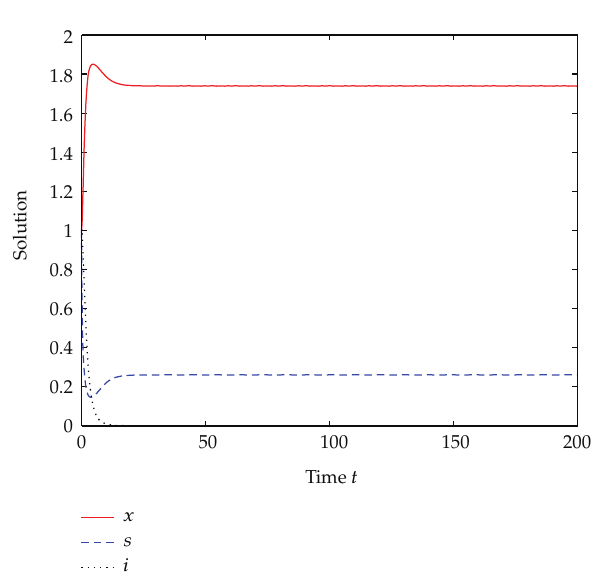
Figure 1: The temporal solution found by numerical integration of system (cid:4) 1.1 (cid:7) with r (cid:8) 2 , K (cid:8) 2 , a (cid:8) 2 , c (cid:8) 2 , β (cid:8) 2 , α (cid:8) 1 , d (cid:8) 0 . 8 , b (cid:8) 0 . 3 , τ (cid:8) 1, and (cid:4) x 0 ,S 0 ,I 0 (cid:7) (cid:8) (cid:4) 1 , 1 , 1 (cid:7)